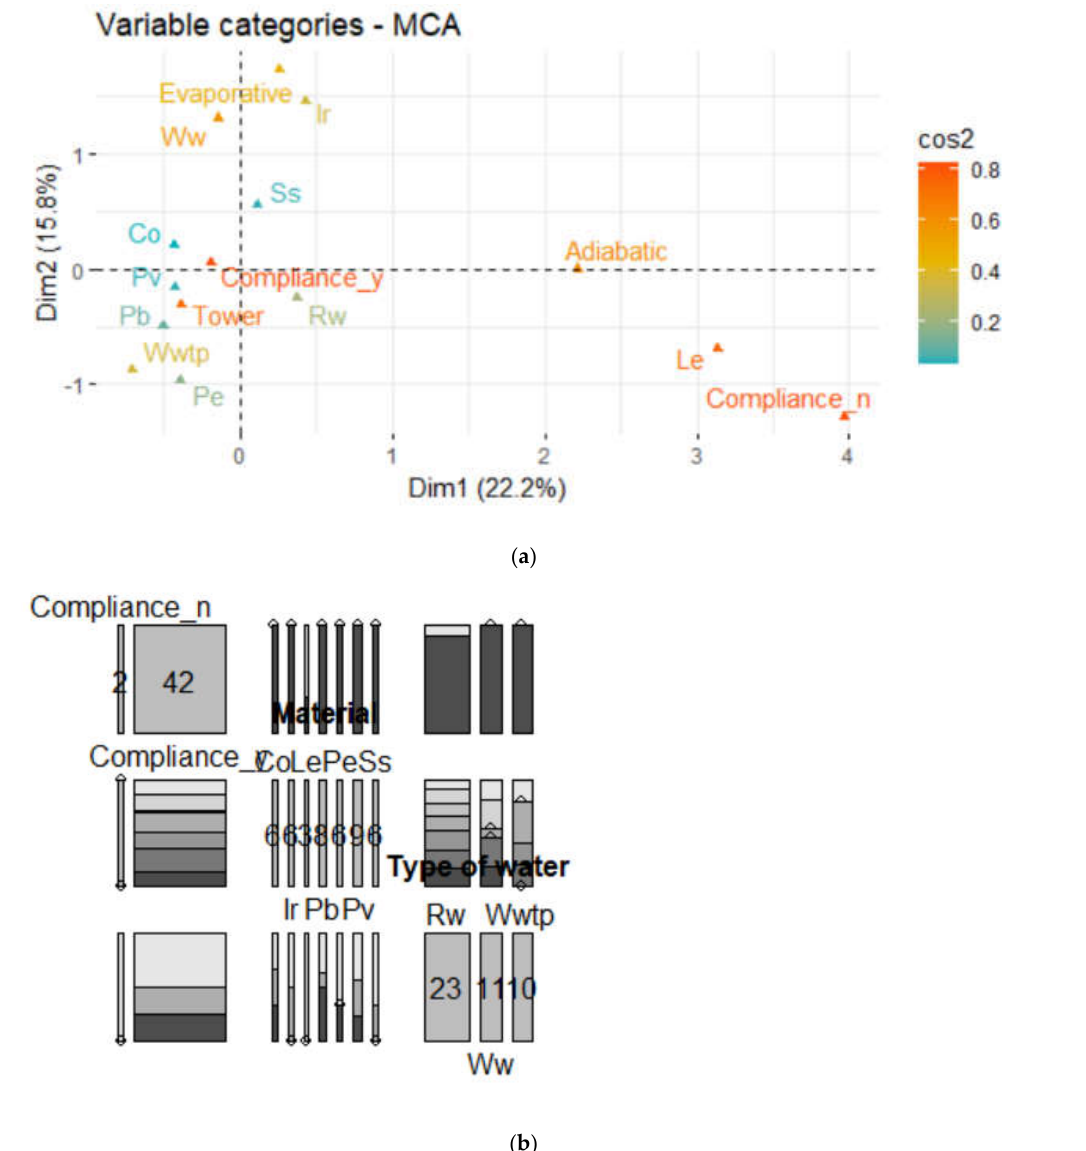
Figure 2. ( a ) Quality of representation of variable categories by MCA. cos2: blue (0–0.2), grey (0.2–0.4), yellow (0.4–0.6), orange (0.6–0.8); ( b ) Mosaic pair plot (legislative compliance, pipe material and type of water).